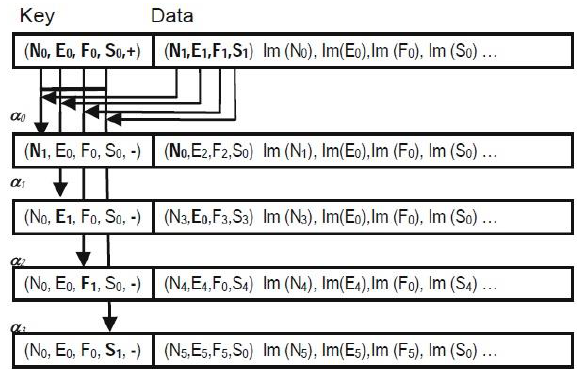
Figure 7 . Cell-tuple representation with combination of involutions (Van Oosterom et al., 2008).